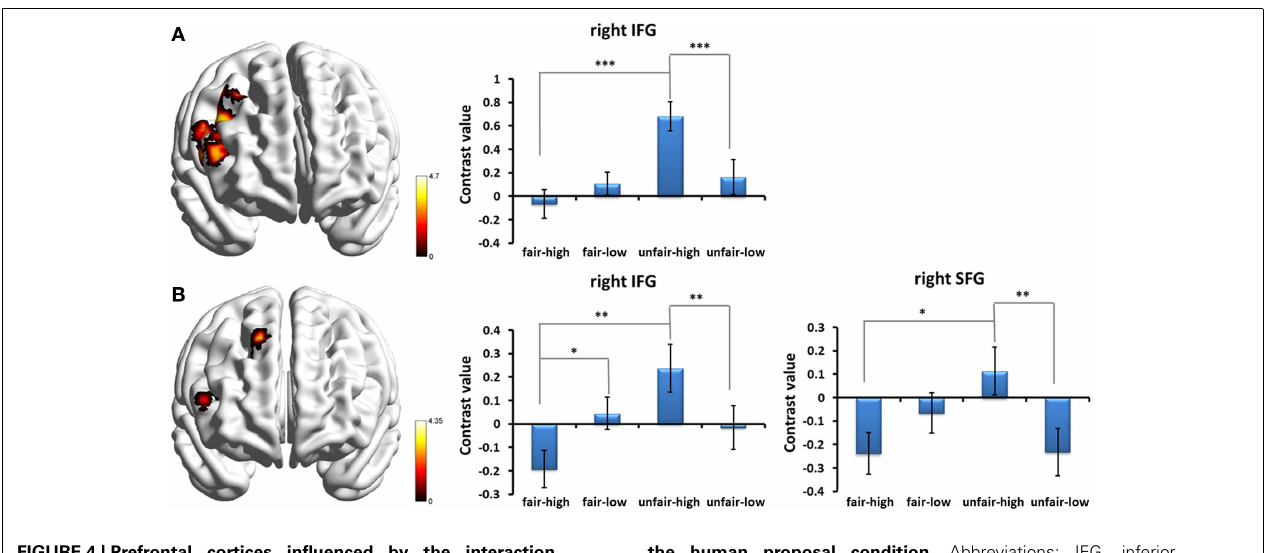
FIGURE 4 | Prefrontal cortices influenced by the interaction between fairness and stake size and simple effects of the interaction effects in (A) all the proposal conditions and (B)